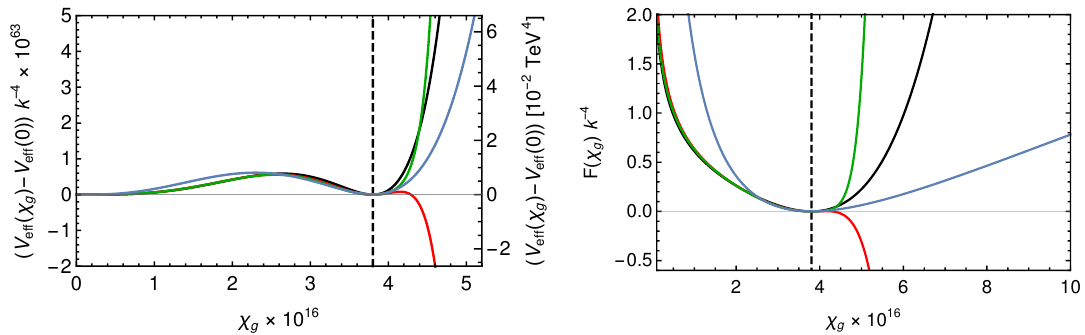
Figure 7 . Exact and approximate e(cid:11)ective potential. The (cid:12)xed parameters are (cid:20) = 0 : 5 k (cid:0) 3 = 2 , (cid:13) = 0 : 1 k (cid:0) 3 = 2 , v 1 = (cid:0) 15 k 3 = 2 , v 2 = (cid:0) 3 : 3 k 3 = 2 , and (cid:3) 2 = (cid:3) (cid:3) = (cid:0) 1 : 719 (cid:2) 6 k=(cid:20) 2 . Then, k = 2 1 : 91 (cid:2) 10 15 TeV (2.27). The blue line is the exact calculation of V e(cid:11) . The black, red and green lines are the approximation up to the (cid:12)rst, second and third order respectively. The vertical dashed line is the value (cid:31) g; 0 = 3 : 8 (cid:2) 10 (cid:0) 16 where the approximation is exact. On the left, we plot V e(cid:11) ( (cid:31) g ) (cid:0) V e(cid:11) (0). The left vertical axis is given in units of k 4 and the right one, in TeV 4 . On the right, we plot F ( (cid:31) g ) = ( V e(cid:11) ( (cid:31) g ) (cid:0) V e(cid:11) (0)) =(cid:31) 4 g